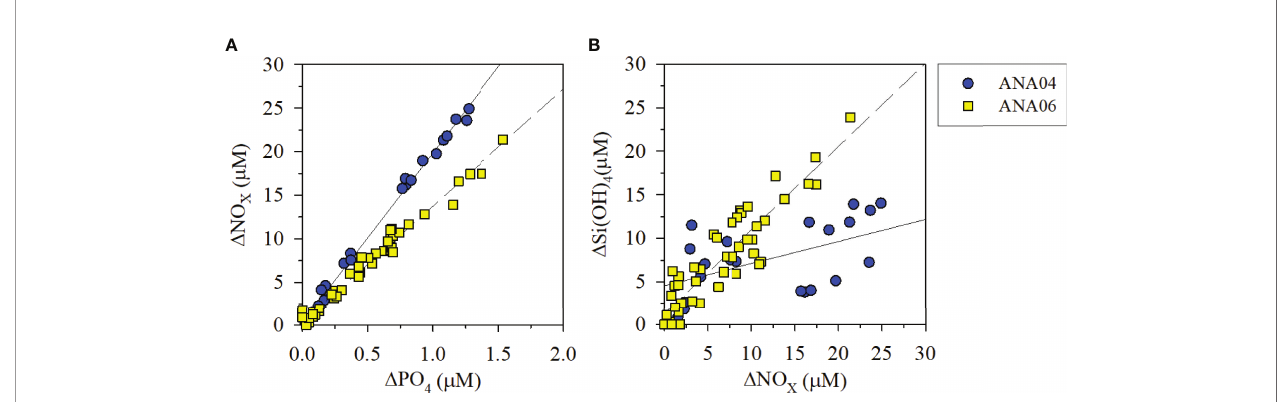
FIGURE 5 | Disappearance ratio of nitrate + nitrite (NO X ) versus phosphate (PO 4 ) concentrations ( A , ANA04: y = 19.53x + 0.42, r 2 = 0.99, p < 0.001; ANA06: y = 13.38x + 0.44, r 2 = 0.98, p < 0.001) and silicate [Si(OH) 4 ] versus NO X concentrations ( B , ANA04: y = 0.25x + 4.56, r 2 = 0.27, p = 0.015; ANA06: y = 0.96x + 1.31, r 2 = 0.82, p < 0.001) during the ANA04 and